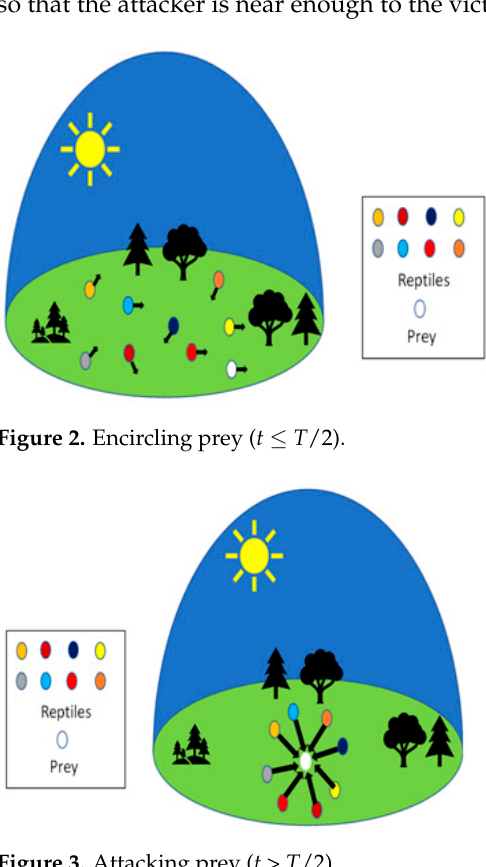
Figure 3. Attacking prey (t > T/2).